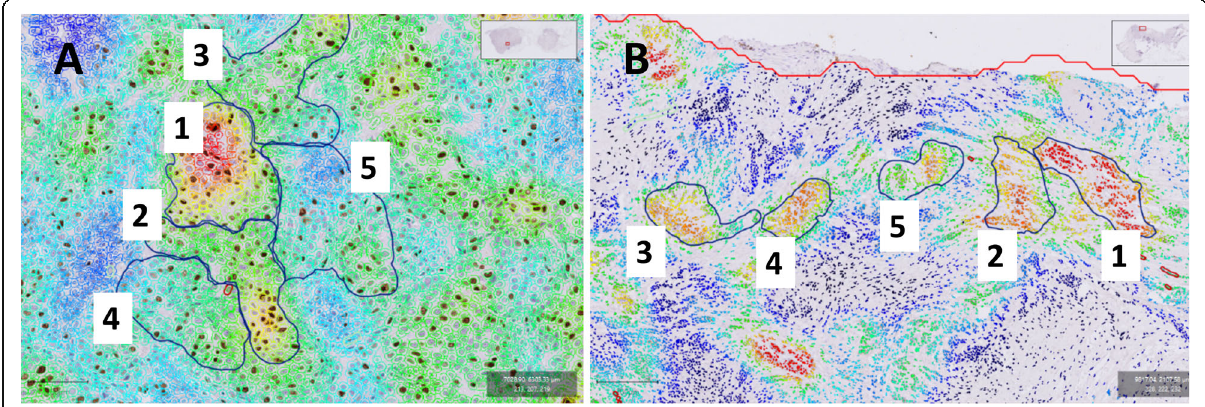
Fig. 4 A and B Hotspot identification and delineation images from QuPath. Areas of 100 tumour cell nuclei ordered from the area with the highest proportion of Ki-67 positive tumour cell nuclei [1] to the lowest